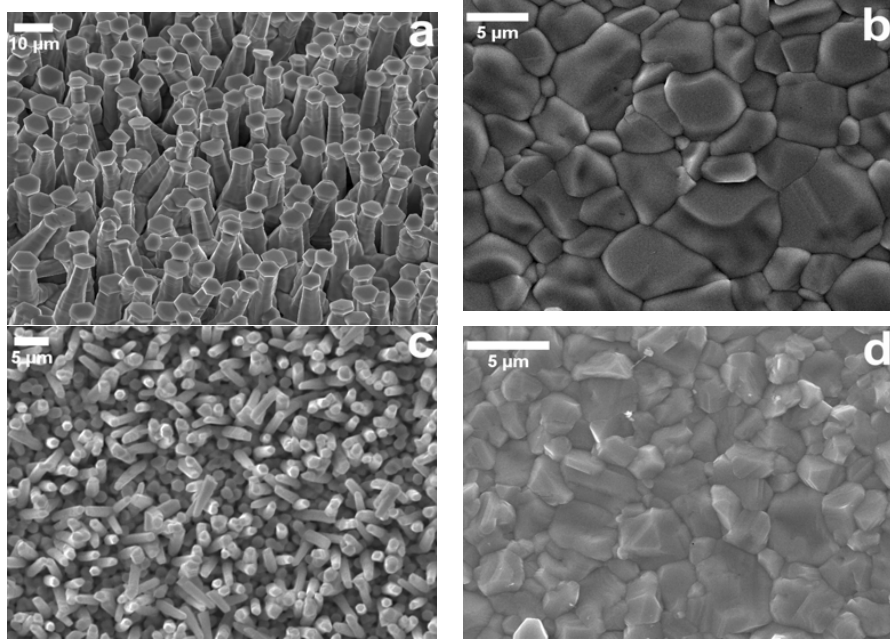
Figure 1. SEM images showing the effect of the substrate on wire growth. CdTe deposition was performed under identical growth conditions on: ( a ) SLG/Mo; ( b ) Mo Foil; ( c ) SLG; and ( d ) SLG/FTO/Mo.